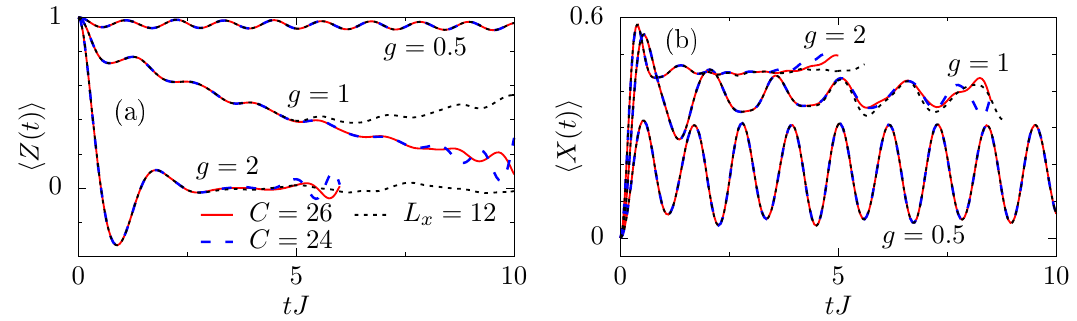
Figure 3: Dynamics of the (a) longitudinal magnetization 〈 Z ( t ) 〉 and (b) transverse magnetization 〈 X ( t ) 〉 , in two-leg ladders with initial state | ψ ( 0 ) 〉 = |↑〉 and dif- ferent transverse fields g . Numerical data obtained by NLCE for expansion orders C = 24,26 are compared to direct simulations for ladders with L